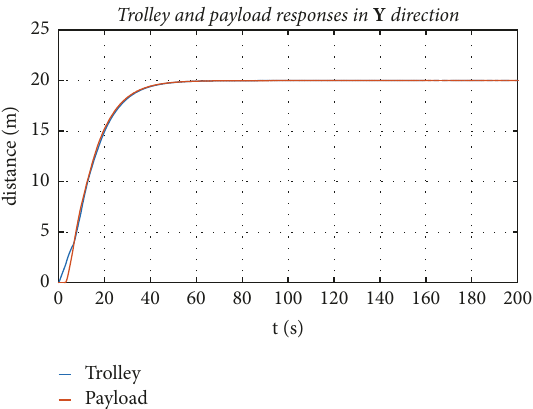
Figure 10: Trolley and payload responses in Y direction with vibration control.